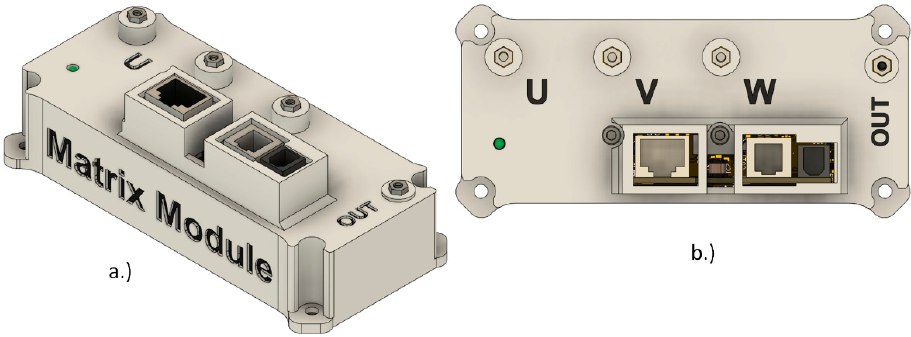
Figure 10. Assembled module: ( a ) Side view ( b ) Top view. Thefinaldimensionsofone3 × 1matrixmoduleare130 × 54 × 43mm(length × width × height).